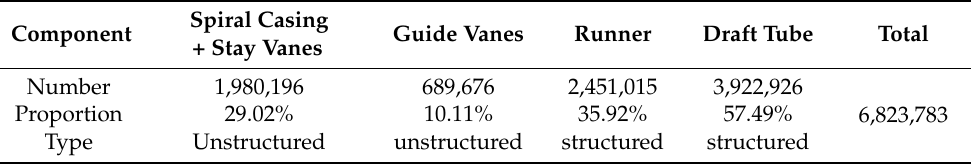
Table 1. Detailed statistics of the mesh.